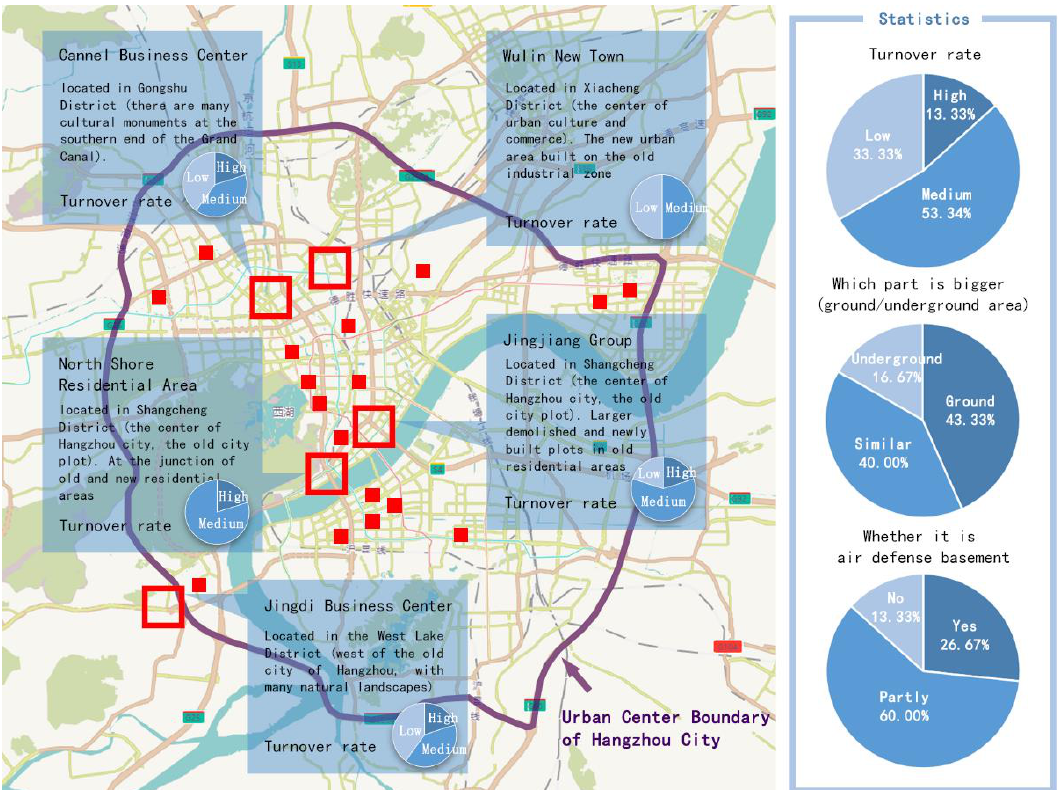
Figure 2. The sample distribution in Hangzhou